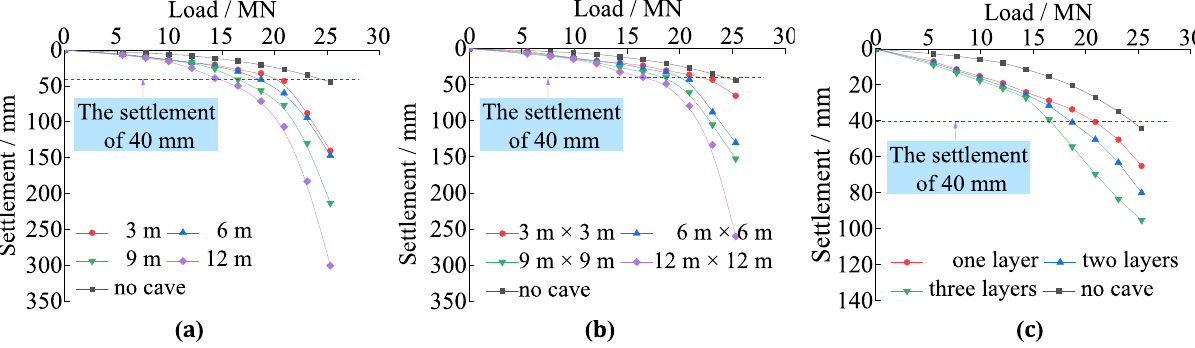
Figure 1. The load–settlement curves of piles under three factors: ( a ) load–settlement curves under different cave’s height; ( b ) load–settlement curve under different cave’s span; ( c ) load–settlement curve under different cave’s